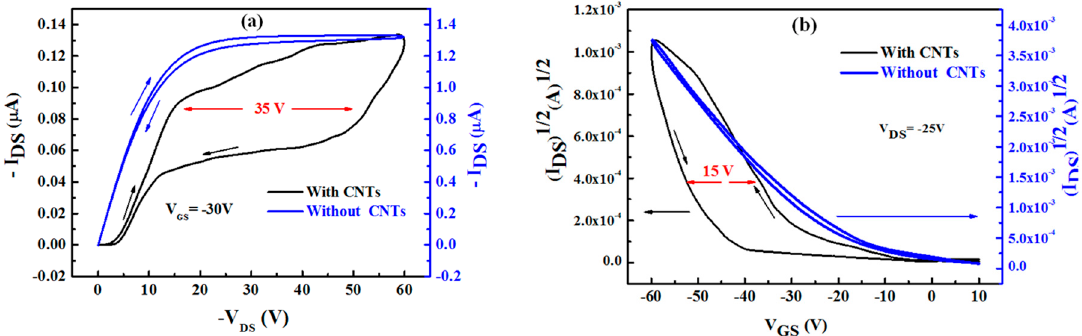
Figure 4. ( a ) The output and ( b ) transfer characteristics of the OTFMT device with and without the SWCNTs floating gate.